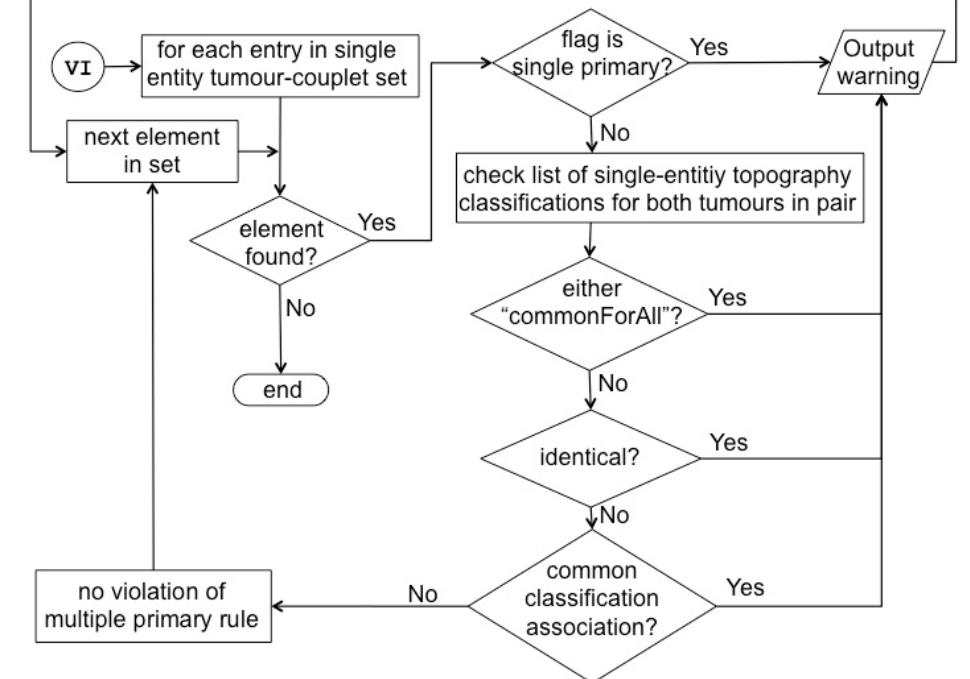
Figure A6. Final stage of the process that ascertains whether a tumour-pair permutation should be considered as a single entity and outputs a warning accordingly. Figure A7 illustrates the results using a programme interface developed along these lines for the same five patient test cases described in Section 3. The topography and morphology codes are shown for each patient. Violation of the MPT rules is indicated with a warning followed by the tumour permutation causing the violation and the reason. Valid MPT test cases are those without warnings.